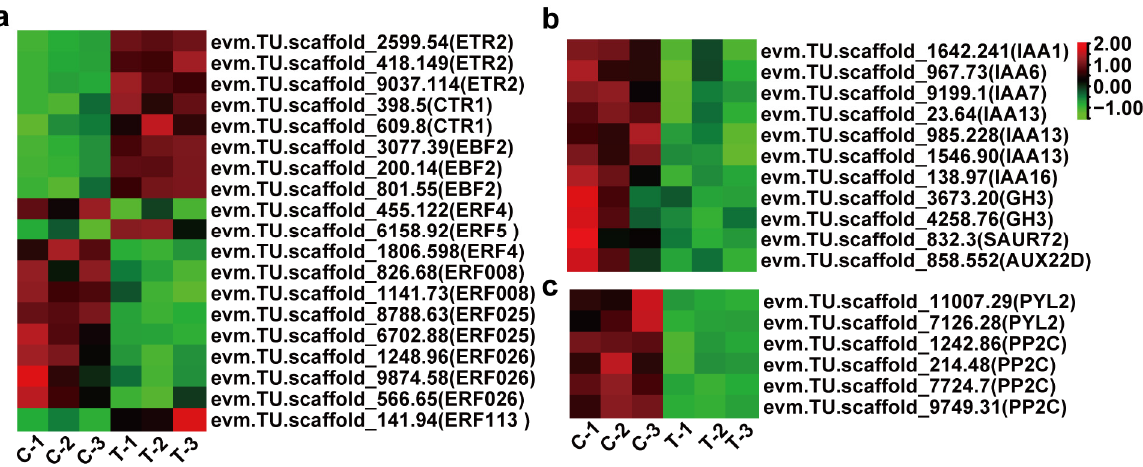
Figure 4. Heat map of di ff erentially expressed genes (DEGs) related to ethylene ( a ), auxin ( b ), and ABA ( c ) signaling pathways between control (water) and ethephon treatments. C-1, C-2, and C-3 represent three control samples. T-1, T-2, and T-3 represent three ethephon-treated samples.